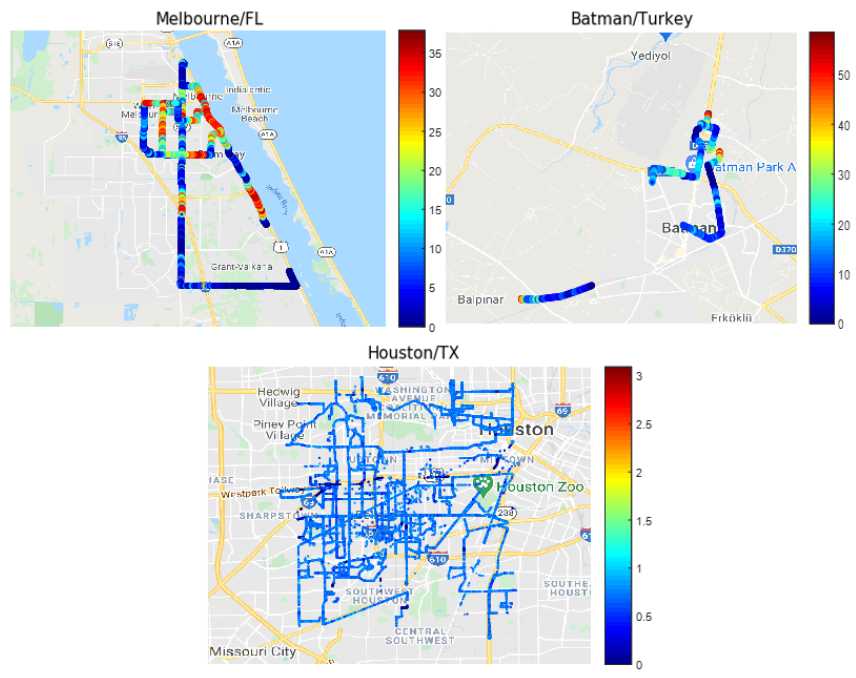
Figure 5. Geomap visualization of UL throughput.